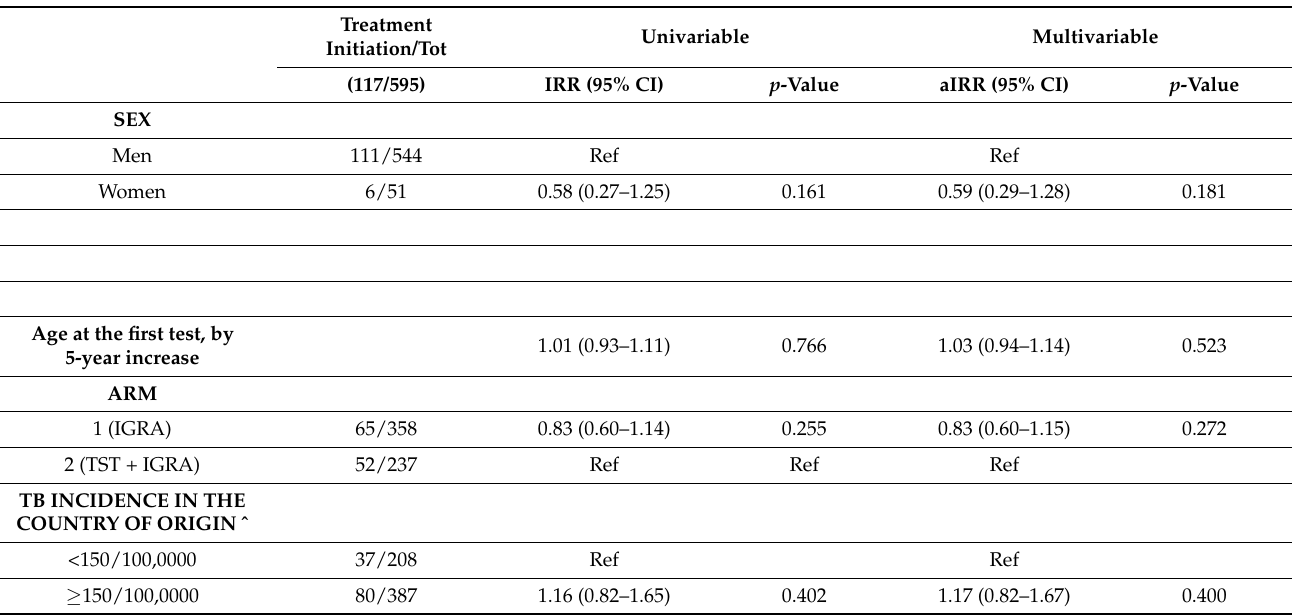
Table 3. Incidence rate ratio (IRR) and 95% confidence intervals (CIs) for preventive treatment initiation. Treatment Univariable Initiation/Tot